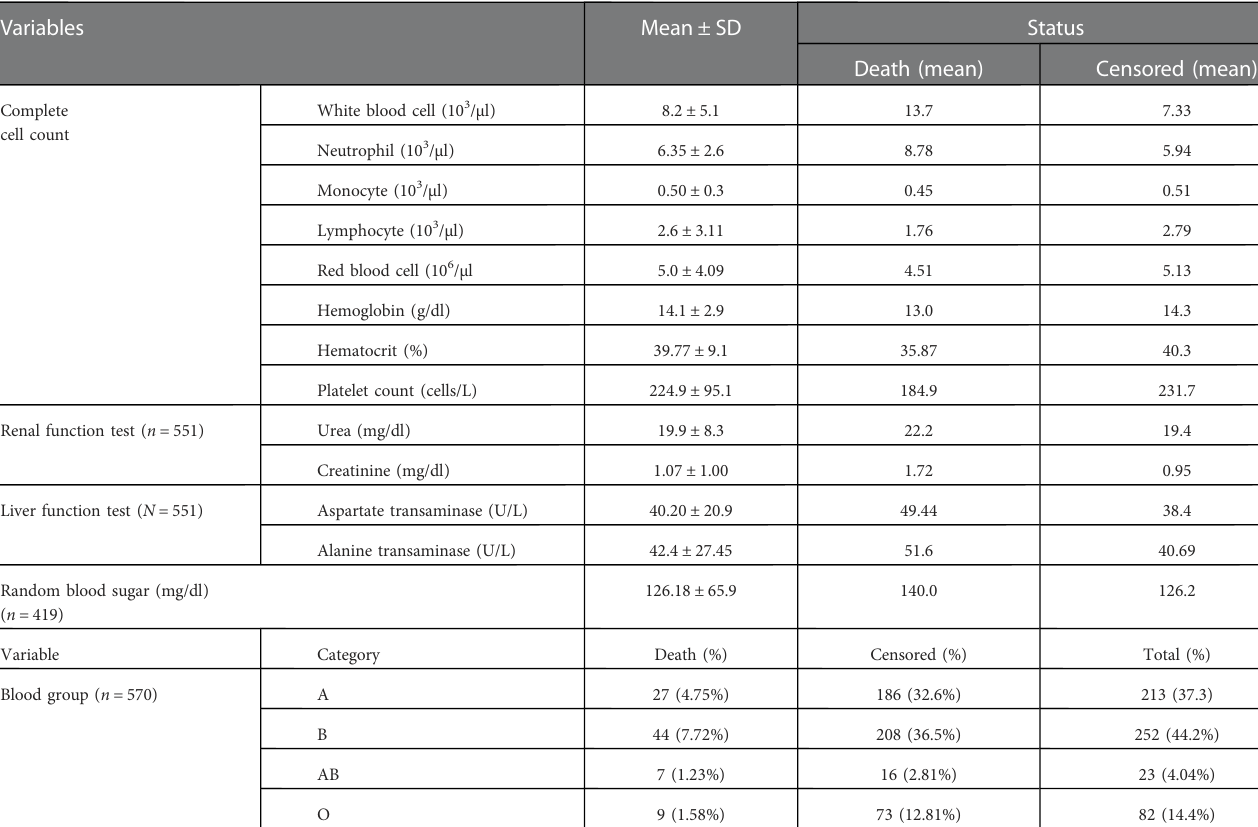
TABLE 1 Baseline laboratory marker of adult COVID-19 patients at Eka Kotebe General Hospital, COVID-19 Treatment Center, Addis Ababa, Ethiopia, 2021 ( n =602).